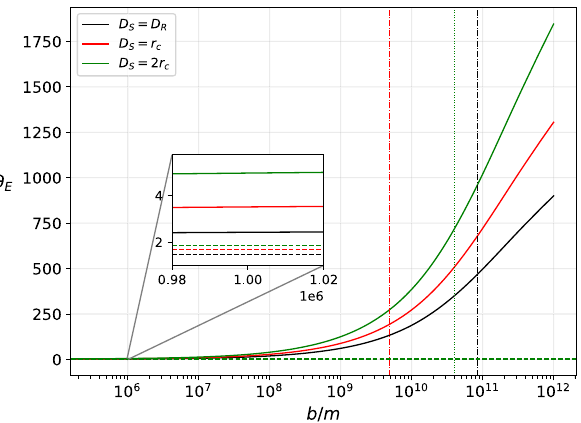
Fig. 7 The angular radius of the Einstein ring for CDM profile in Sgr. A*. Here, θ E is in µ as. We used the same parameters present in the weak deflection angle plots, except for D R = 8 . 3 kpc, represented by the green dotted